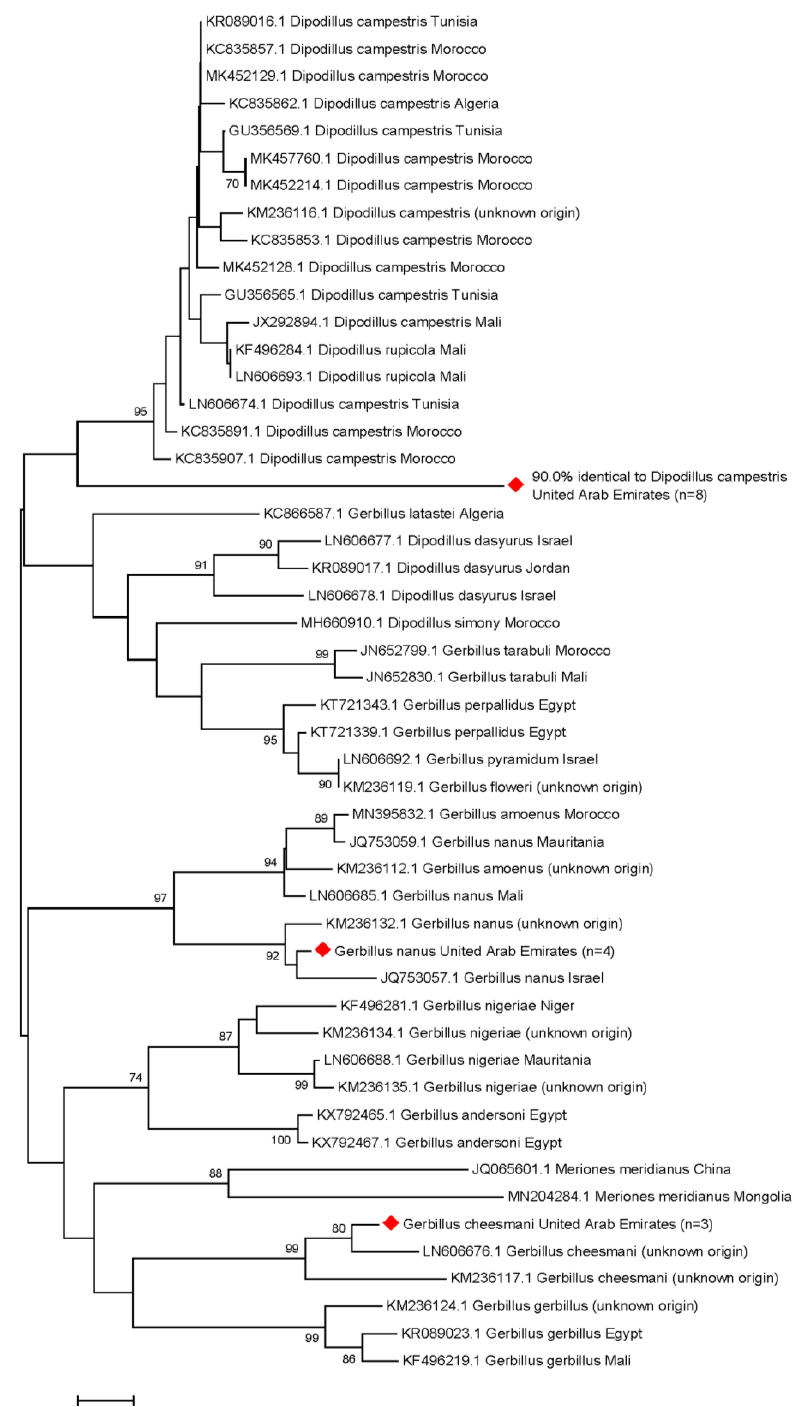
Figure 2. Phylogenetic tree of partial genomic sequences of Gerbillus , Dipodillus and Meriones species. Sequences that were generated in this study are indicated by red diamonds and represent groups of several individuals. Four of the herpesvirus-positive gerbils were identified as Gerbillus nanus , and three as Gerbillus cheesmani . Eight individuals clustered together in a separate clade, 90.0% identical to Dipodillus campestris . The sequences of the remaining four individuals were not analyzable. Phylogenetic analysis was performed on a 239-bp fragment within the cytb gene. For each reference sequence, the corresponding GenBank accession number, species name and country of origin are indicated (where known). Horizontal lines represent the genetic distances according to the scale at the bottom. Bootstrap values ≥ 70% are displayed at the